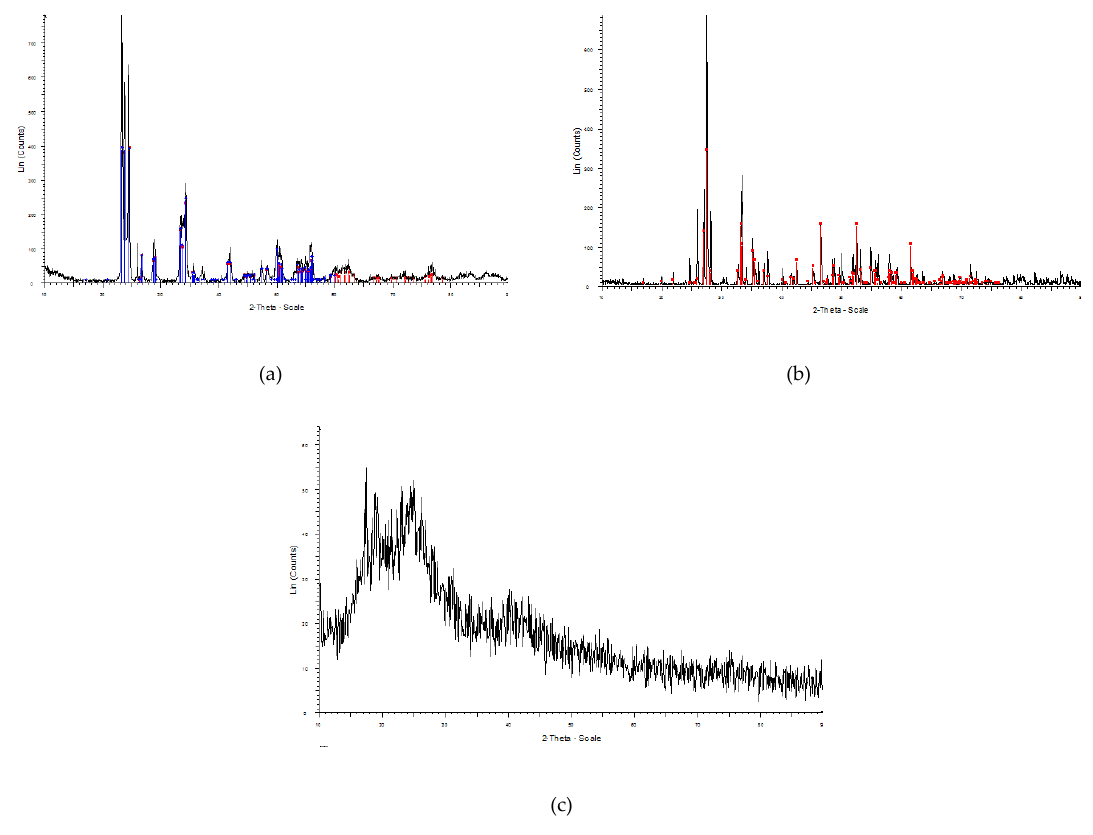
Figure 3. XRD pattern of: ( a ) WO 3 nano powder; ( b ) Bi 2 O 3 micro powder; ( c ) polyvinyl chloride (PVC) with the peaks similar to the reference patterns.